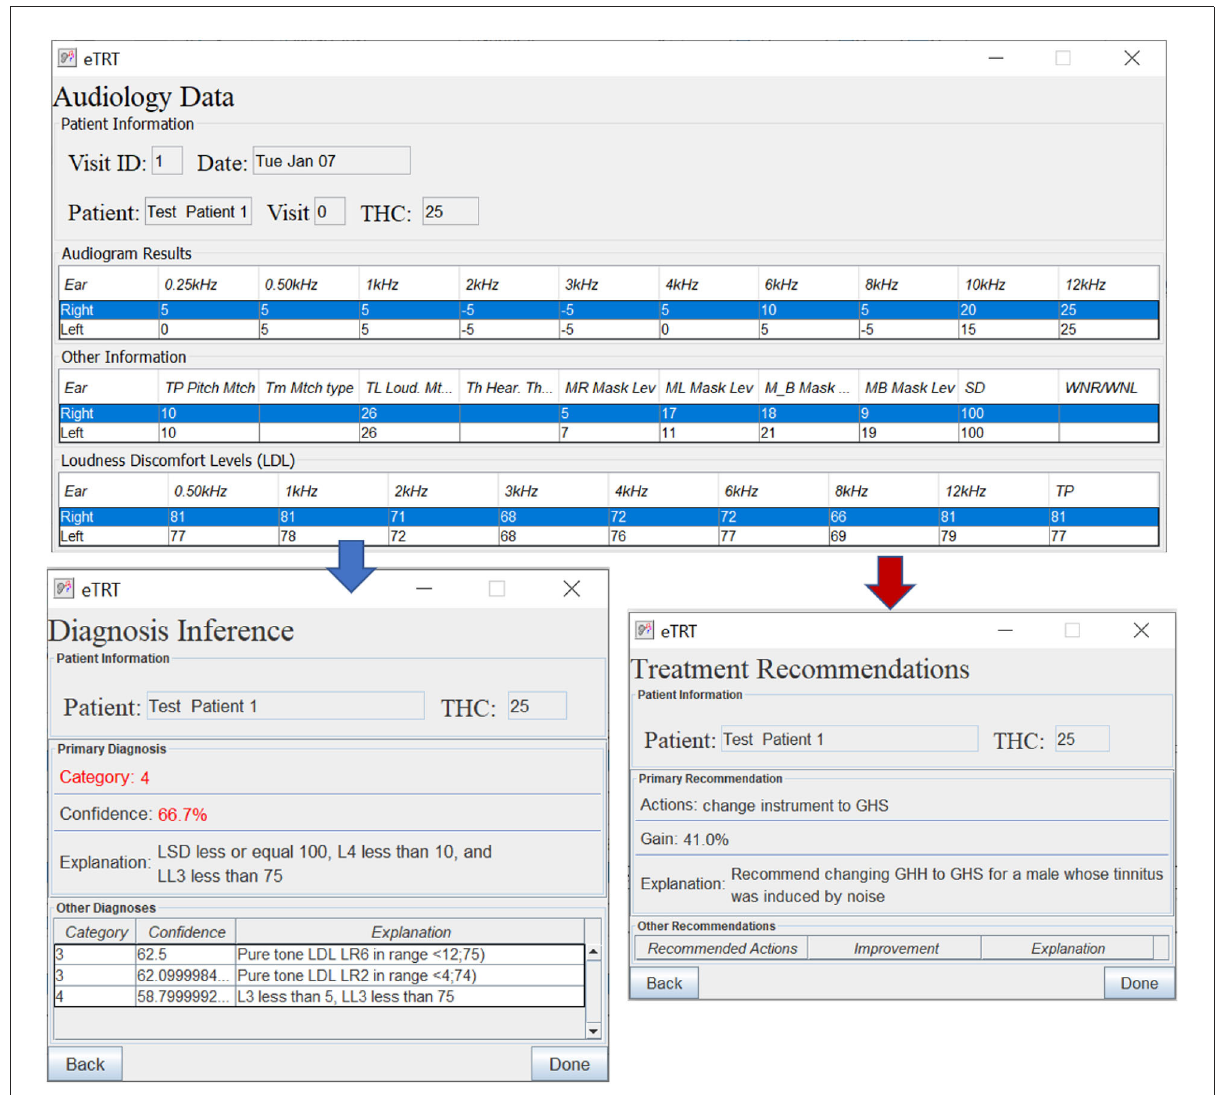
FIGURE5 The diagnostic/treatment inference results for test case 1 (noise-based, middle-aged male) based on audiometry: (1) primary diagnosis of category 4 with 66.7%, and (2) treatment recommendation for changing the instrument type with the expected decrease in tinnitus severity by 41%